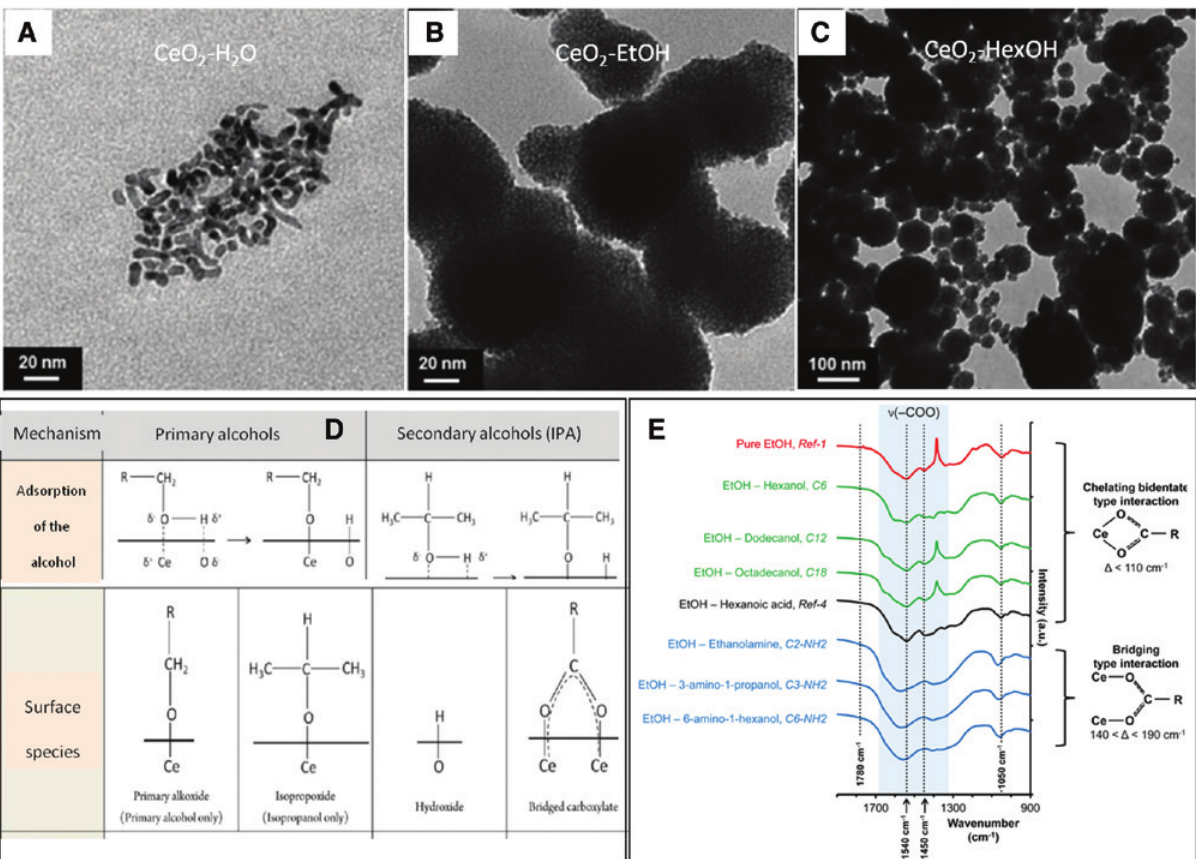
Figure 22: Ceria NPs prepared in supercritical alcohol and their derivatives, and ceria surface modification by the alcohol solvent. (A) Ceria NCs prepared in sc-H O as reference; (B) ceria prepared in sc-ethanol; and (C) ceria prepared in sc-hexanol. (D) Proposed mechanism of the 2 surface reaction of primary and secondary alcohols with ceria. Reprinted with permission from Slostowski C, Marre S, Babot O, Toupance Th, Aymonier C, Langmuir 2012, 28, 16656–16663 [21], Copyright 2012 American Chemical Society. (E) FTIR and the surface species at the hybrid interface when supercritical alcohol derivatives are used for the ceria synthesis. Reprinted with permission from Slostowski C, Marre S, Babot O, Toupance Th, Aymonier C, Langmuir 2014, 30, 5965–5972 [22], Copyright 2014 American Chemical